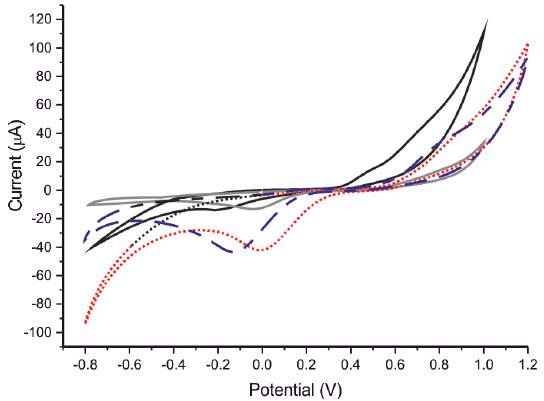
Figure 2. Cyclic voltammograms registered in in catechol 10 − 3 mol·L − 1 (0.01 M phosphate buffer as electrolyte): AuNP NBr (light grey), ZnPc SR (dashed blue), AuNP NBr /ZnPc SR (dashed red) and AuNP NBr -S-ZnPc R (black). Scan rate 100 mV·s − 1